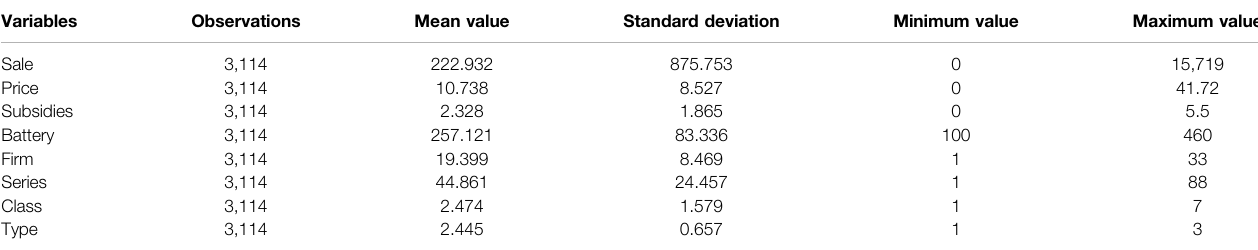
TABLE 1 | Detailed list of national subsidy policies for EVs in China (10,000 Yuan). Endurance mileage of power battery R (km)